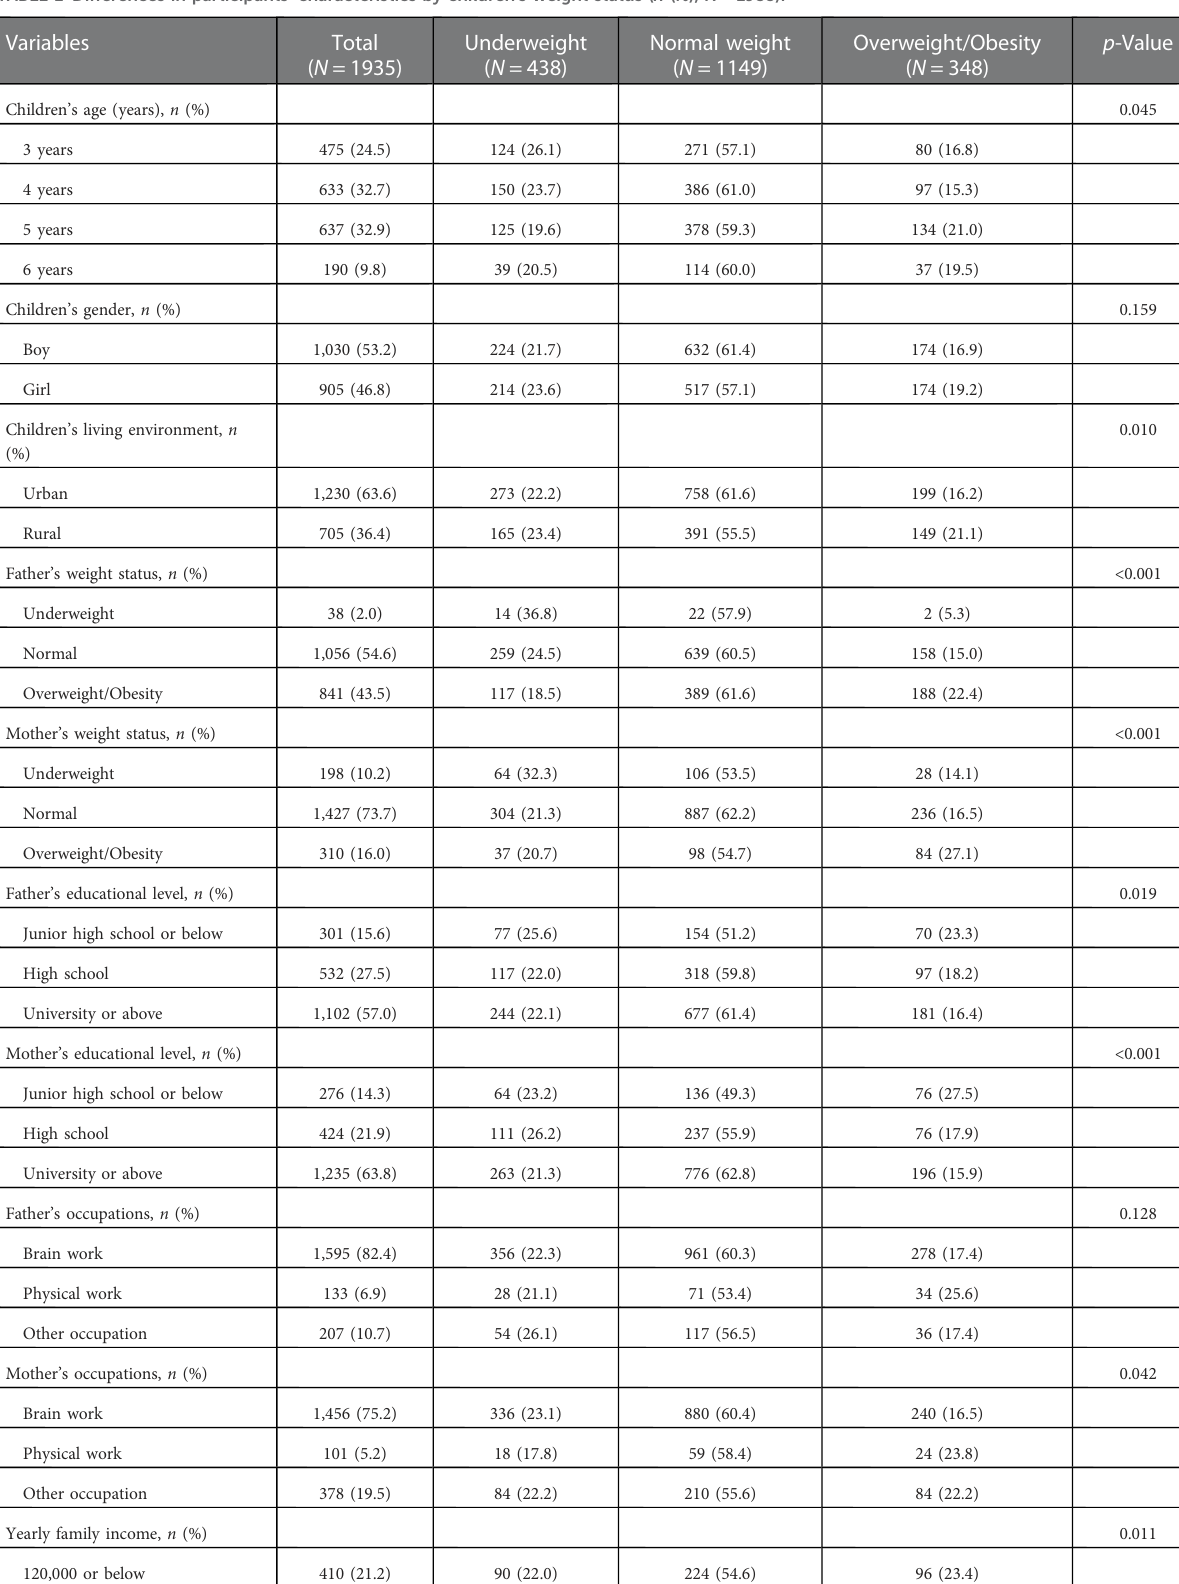
TABLE 1 Differences in participants ’ characteristics by children ’ s weight status ( n (%), N